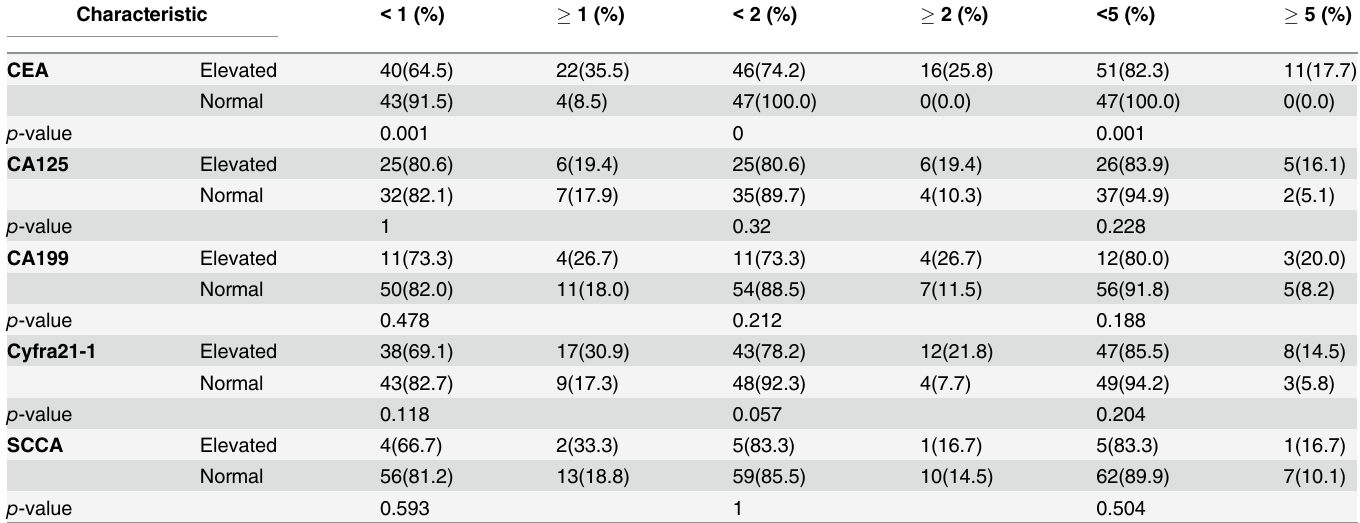
Table 5. Association between CTC counts and tumor marker data from NSCLC patients.